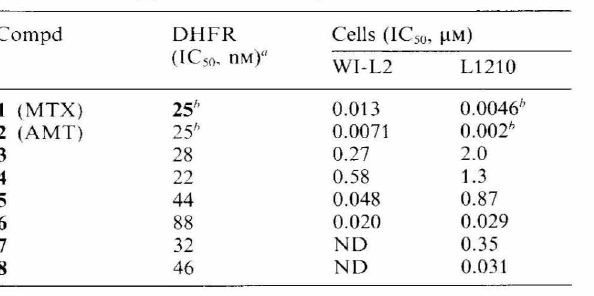
Table 1. Biological activity of ~.y-methanoMTX (3). ~.y­ methanoAMT (4) and related